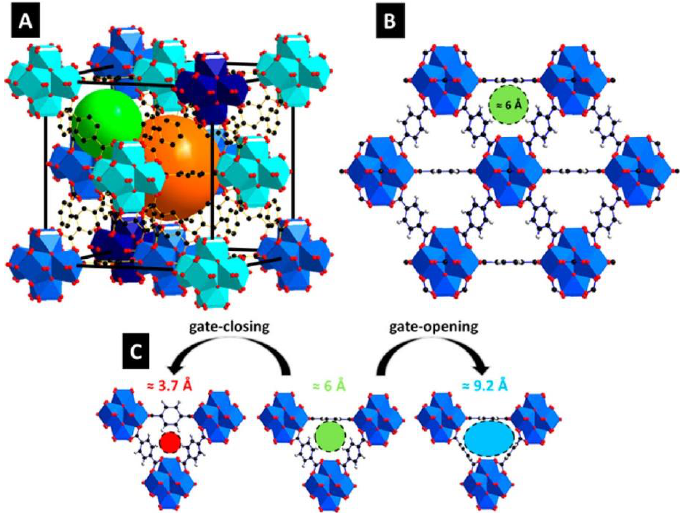
Figure 5. Three-dimensional (3D) structure of UiO-66 ( A ) visualizing the octahedral cage (orange) and the tetrahedral cage (green). Triangular windows ( B ) between the octahedral and tetrahedral cages. Pore opening changes upon rotation of the benzene ligands ( C ) [84], with copyright permission from © 2017, American Chemical